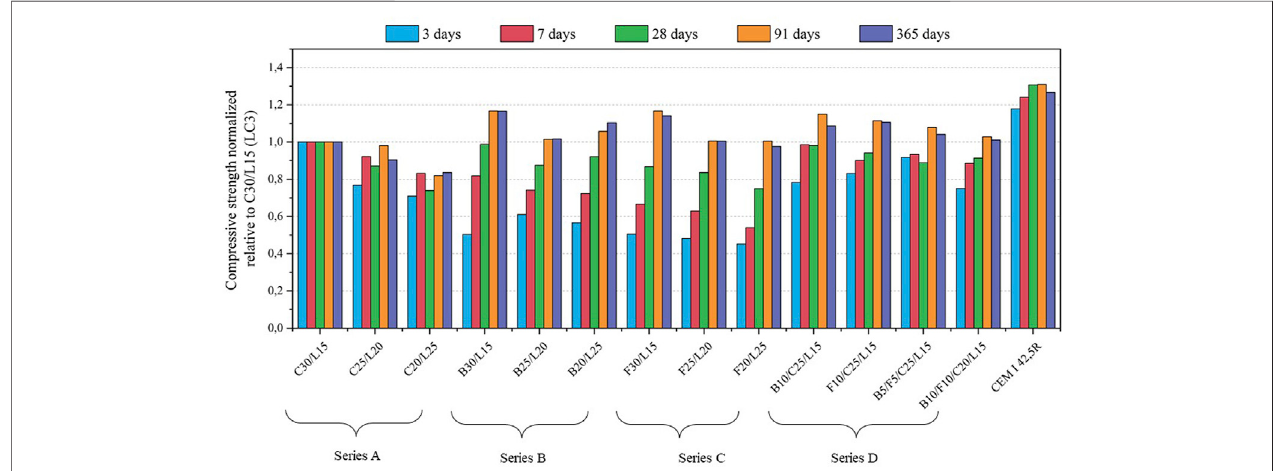
FIGURE 4 | Compressive strength of blended cements normalized relative to C30/L15(LC 3 ) at 3, 7, 28, 91 and 365 days.